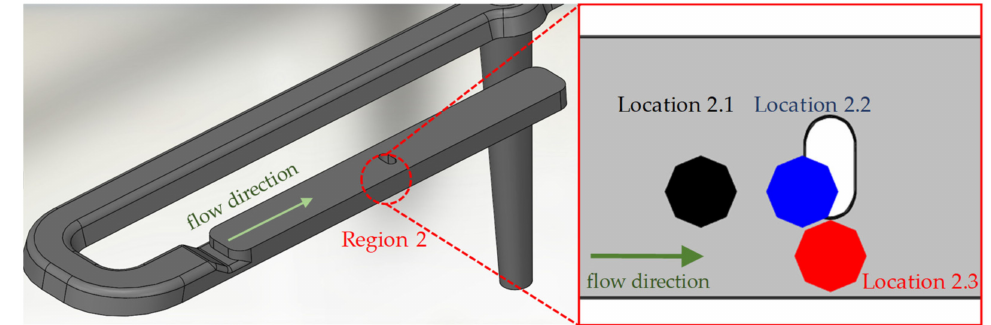
Figure 3. Positions of µ CT-investigation in the area of the notch (region 2), subdivided into simple